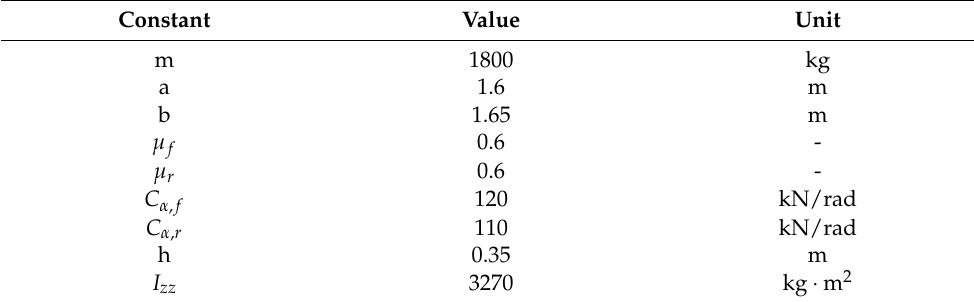
Table A1. Simulation model